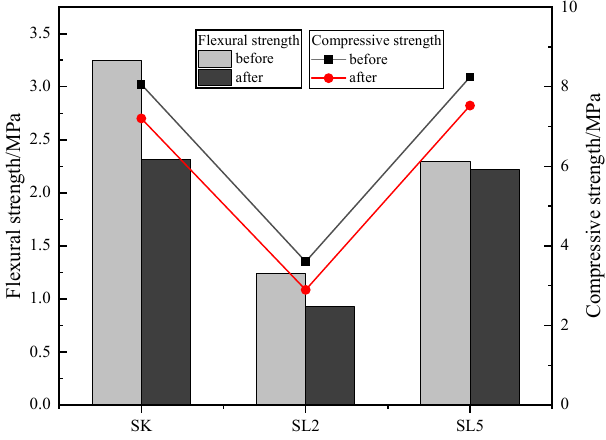
Figure 10. Strength comparison in water immersion.